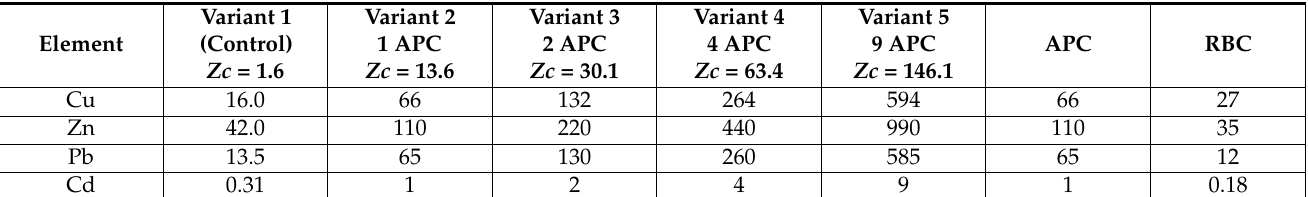
Table 1. Element concentrations for different variants of experiment,